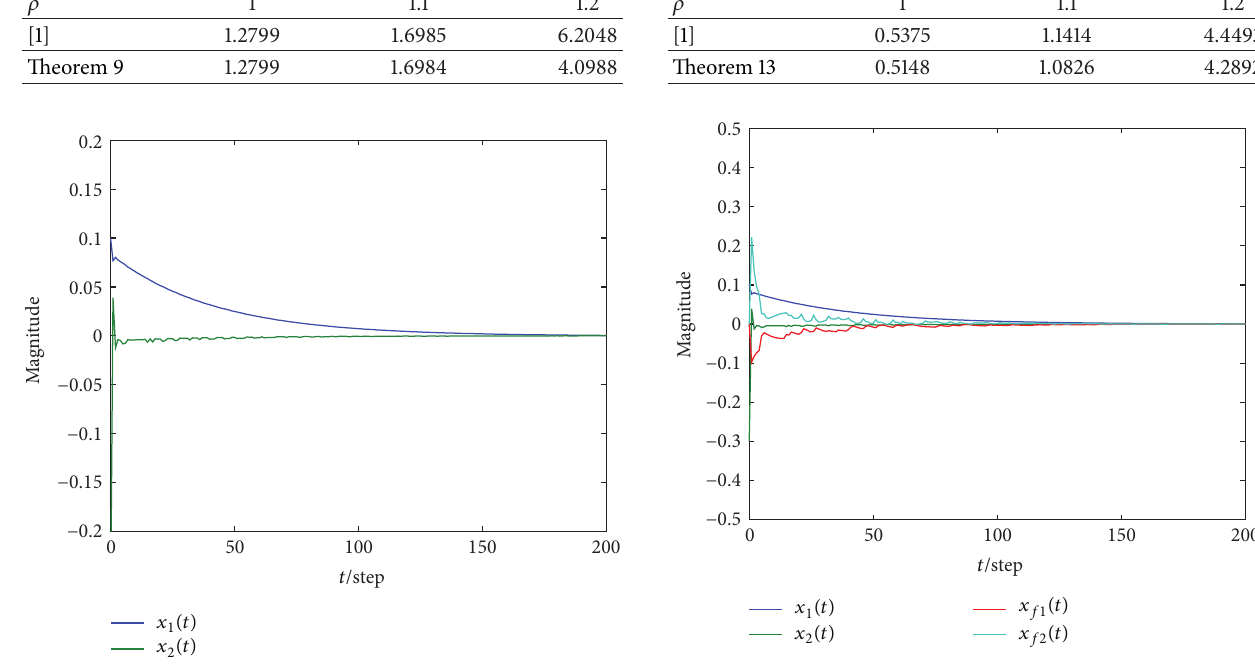
Figure 3: The states responses corresponding to uncertain parame- ters 𝜆 1 = 0.4 and 𝜆 2 = 0.6